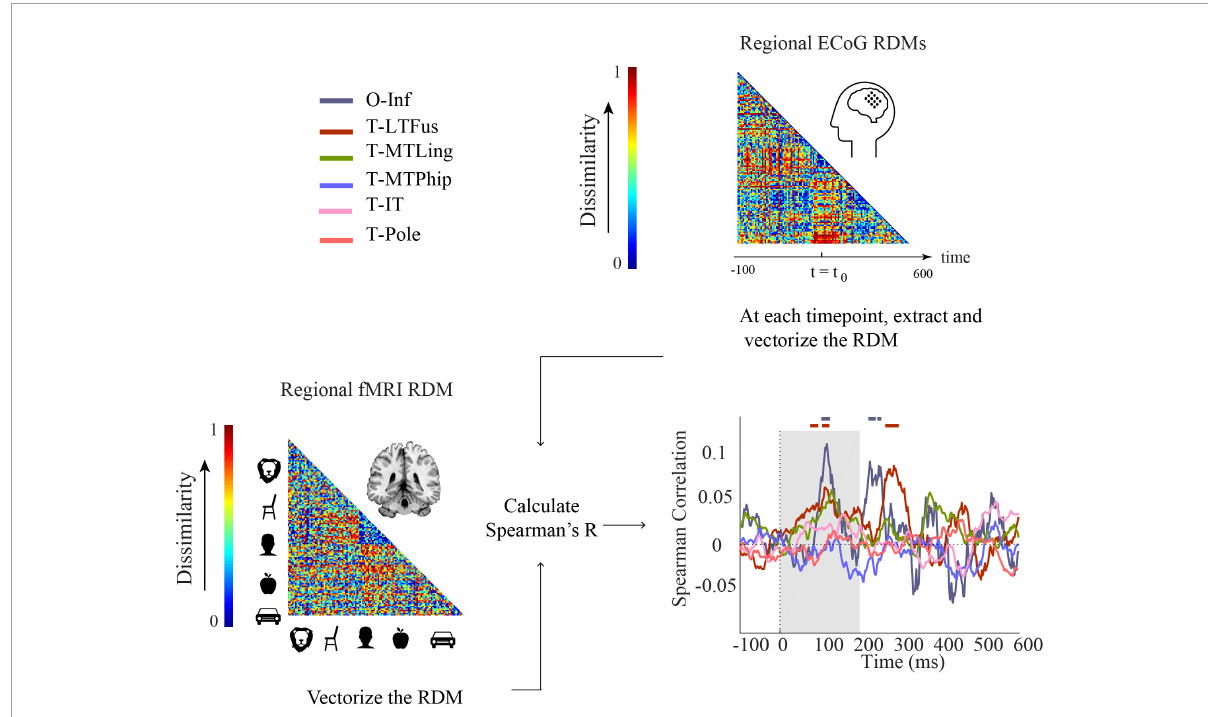
FIGURE5 Comparison of fMRI and ECoG in representational similarity by cortical regions. For each participant, fMRI RDMs were calculated using 1-Spearman’s correlation. We then compared the mean fMRI RDM to the ECoG regional RDMs. The horizontal lines above the curves indicate significant time points (permutation test over stimuli, 10,000 repetitions, FDR-corrected at p < 0.05). The ROIs include occipital-inferior (O-Inf), fusiform (T-LFus), lingual (T-MLing), parahippocampal (T-MTPhip), inferior-temporal (T-IT), and pole-temporal cortex